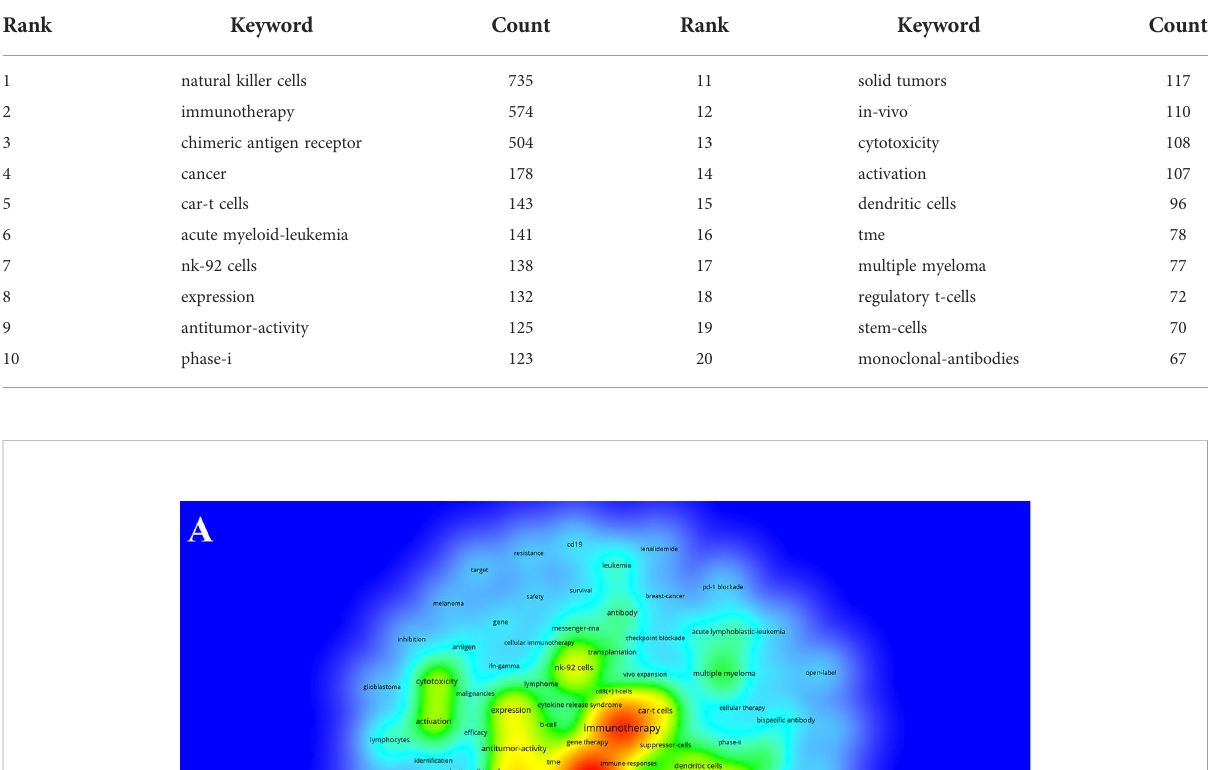
TABLE 4 Top 20 keywords related to CAR-NK cells.